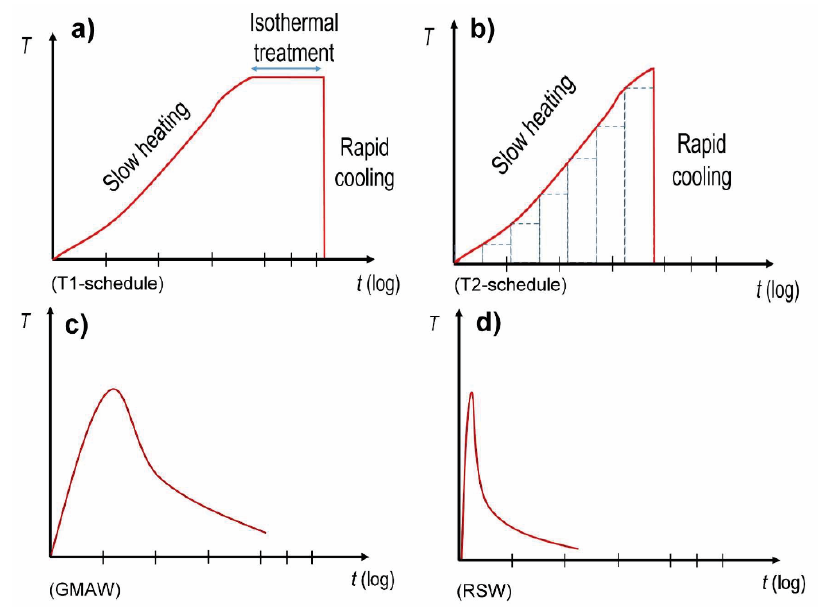
Figure 2. Schematic of the thermal cycles applied to DP980 steel: ( a ) T1-schedule, ( b ) T2-schedule, ( c ) GMAW and ( d ) RSW.